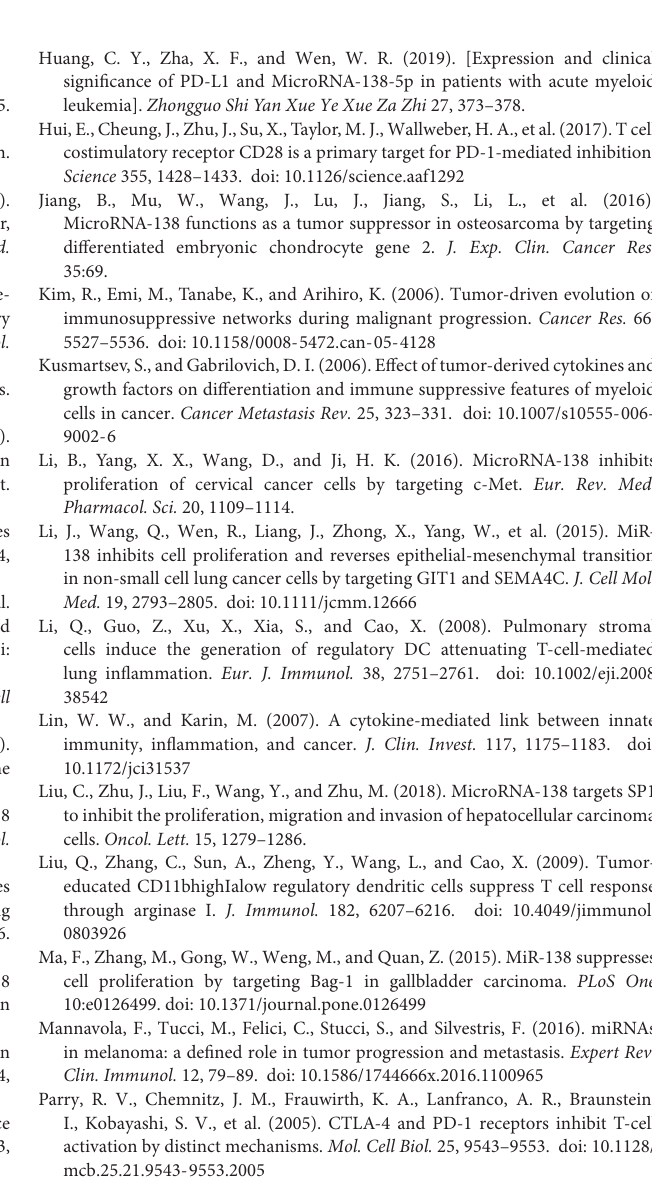
FIGURE S4 | The transduction efficiency of lent-miR-138-5p-GFP in DCs and T cells.